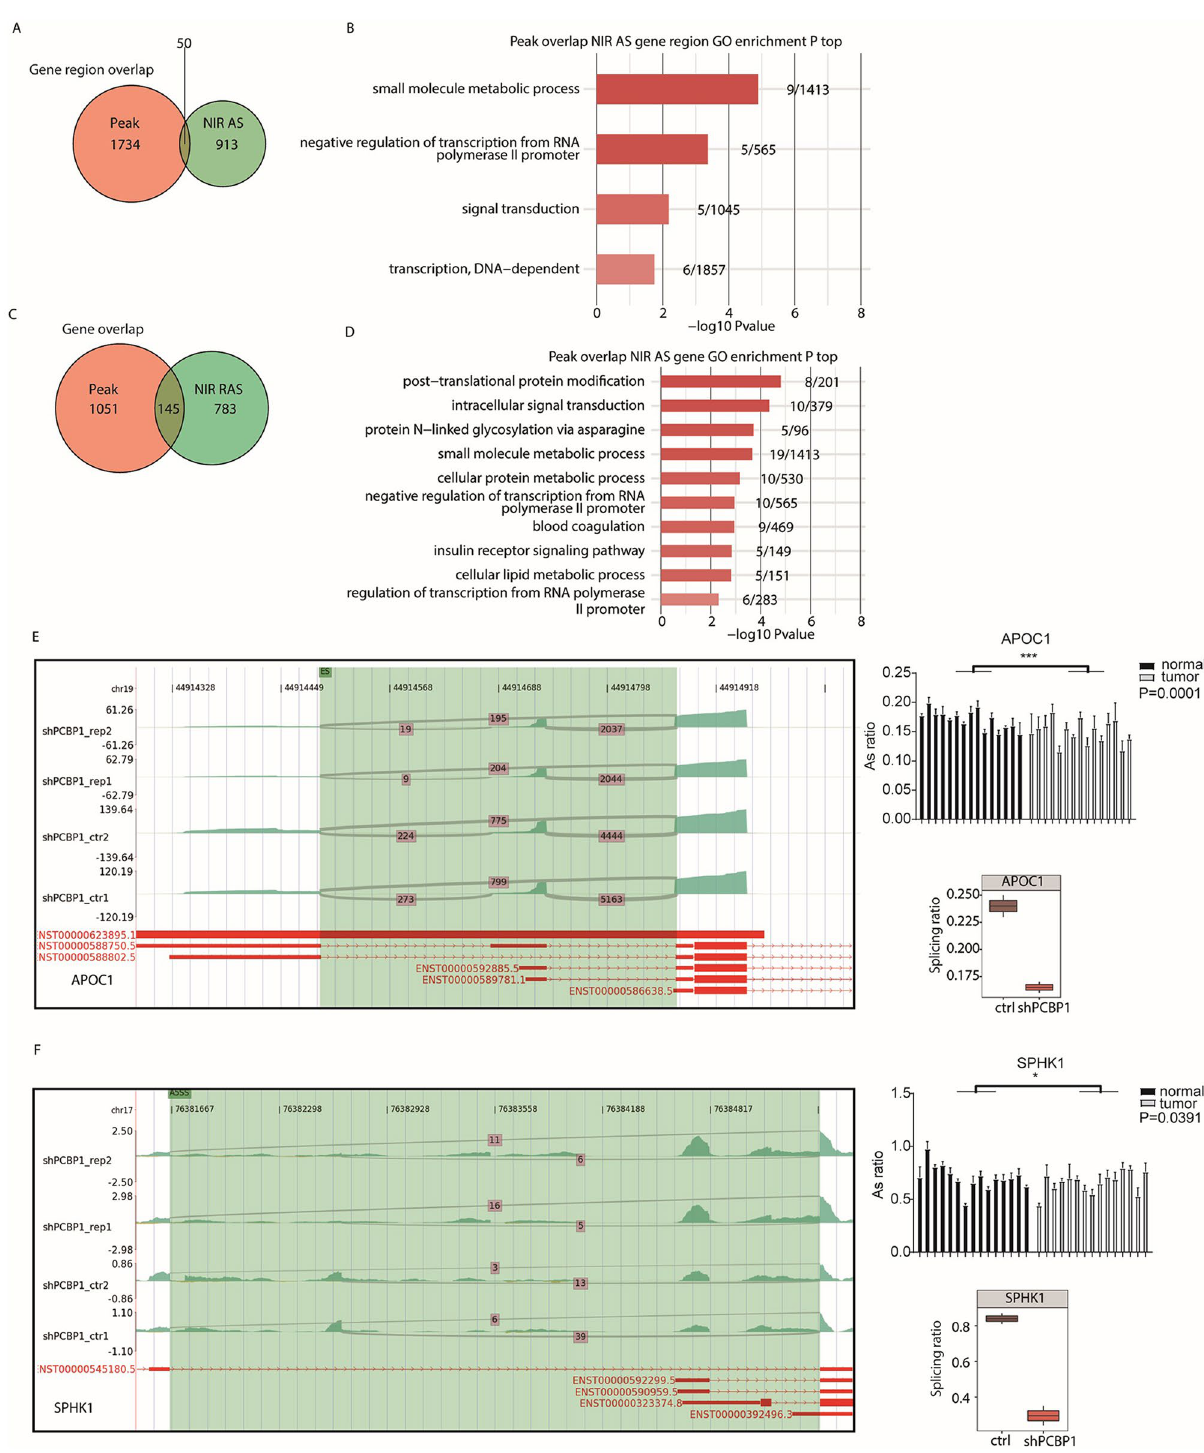
Figure 4. PCBP1 selectively binds to mRNA to regulate alternative splicing. ( A ) Venn diagram showing the overlap of PCBP1-bound peaks and PCBP1-regulated alternatively NIR splicing events (use NIR region), and the PCBP1-bound peaks is the union of two IP samples, bound peaks cluster (several peaks will appear together, which can be considered as one peak). ( B ) Bar plot exhibited the most enriched GO biological process results of the overlap peak genes in Fig. ( A ). ( C ) Venn diagram showing the overlap of PCBP1- bound peaks and PCBP1-regulated alternatively NIR splicing events (Use Symbol), and the PCBP1-bound peaks is the union of two IP samples. ( D ) Bar plot exhibited the most enriched GO biological process results of the overlap peak genes in Fig. ( C ). ( E ) IGV-sashimi plot showed the alternative 3 ′ splicing sites events (A3SS) in CELF1. Reads distribution of each alternative splicing event was plotted in the left panel with the transcripts of each gene shown below. The schematic diagrams depict the structures of ASEs. ( F ) IGV-sashimi plot showed the alternative 5’ splicing sites events (A5SS) in SPHK1. Reads distribution of each alternative splicing event was plotted in the left panel with the transcripts of each gene shown below. The schematic diagrams depict the structures of ASEs. PCBP1, Poly C Binding Protein 1; mRNA, messenger ribonucleic acid; NIR, non-intron-retention regulated; GO, gene ontology. IGV, The Integrative Genomics